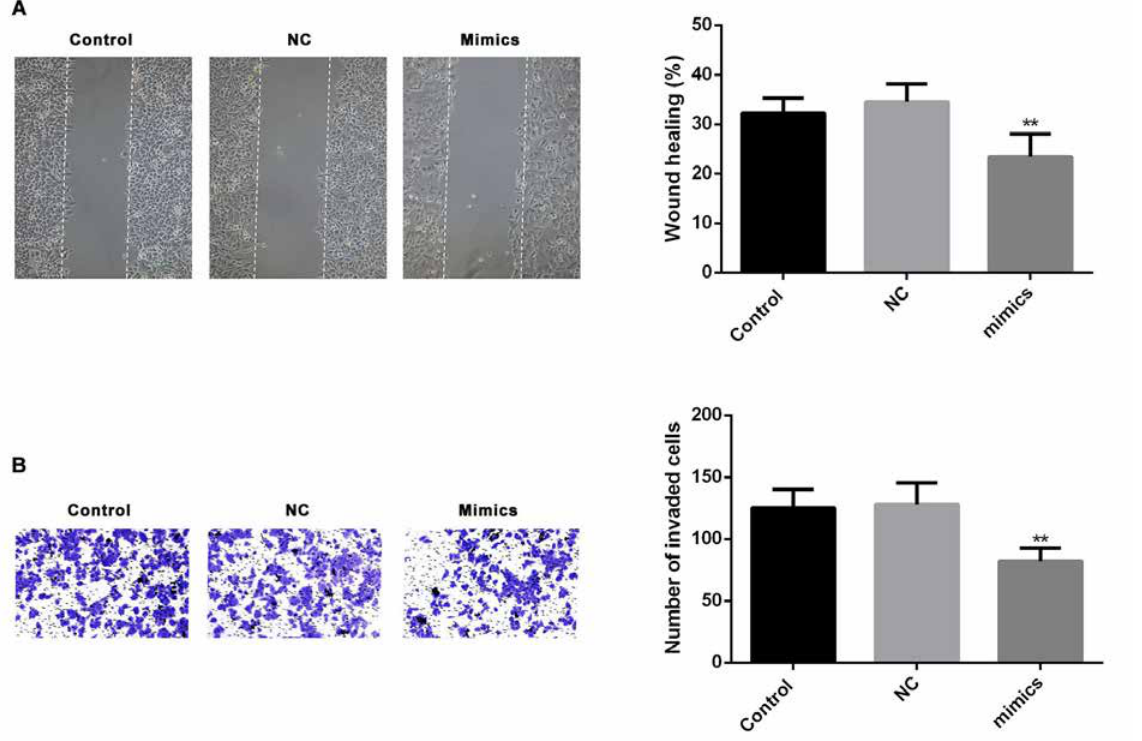
Figure 7: Effect of of miR-16-1-3p on PM2.5 induced metastasis in SMMC-7721 cells (A) Scratch wound assay was used to assess the effect of miR-16 on SMMC-7721 migration at 24 h after PM2.5 treatment. Photographs were taken at 24h after scratch injury under ×200 original magnification. (B) Effect of miR-16-1-3p on invasion ability was measured using trans- well assays in PM2.5 treated SMMC-7721